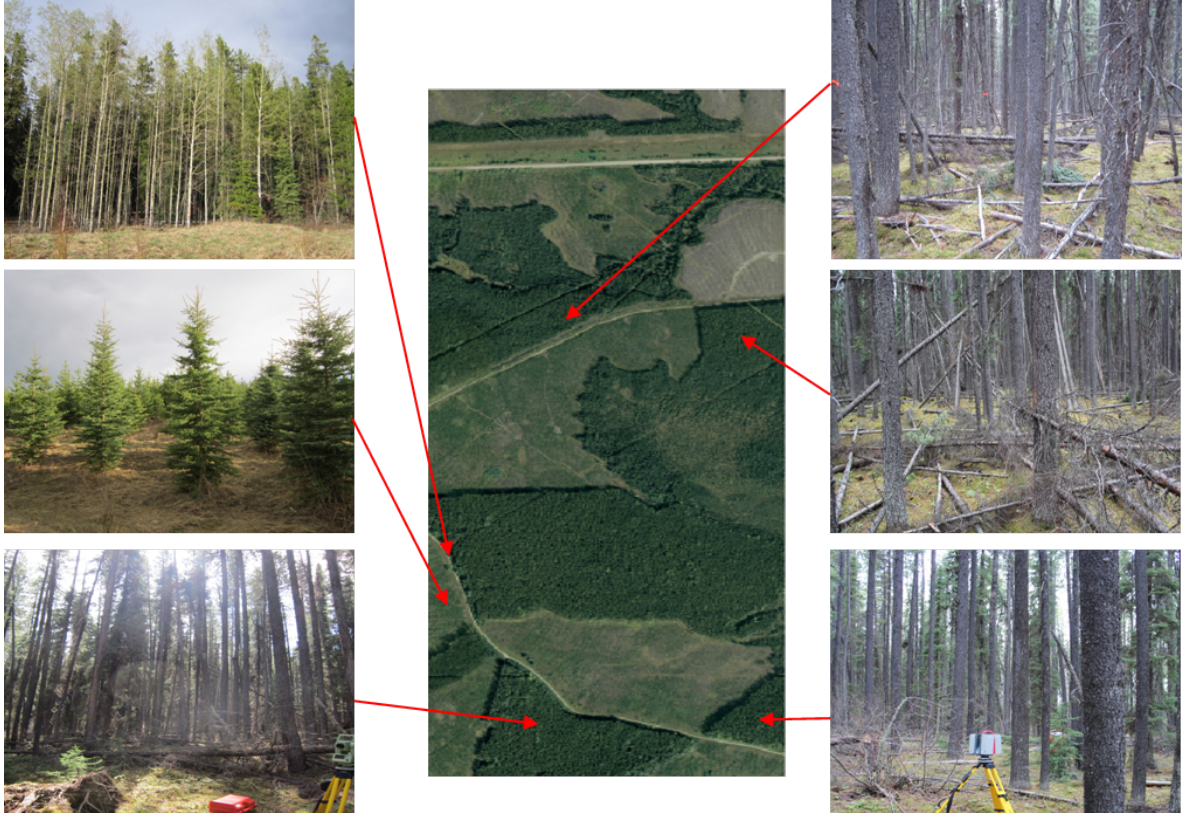
Figure 1. Illustration of the Edson test